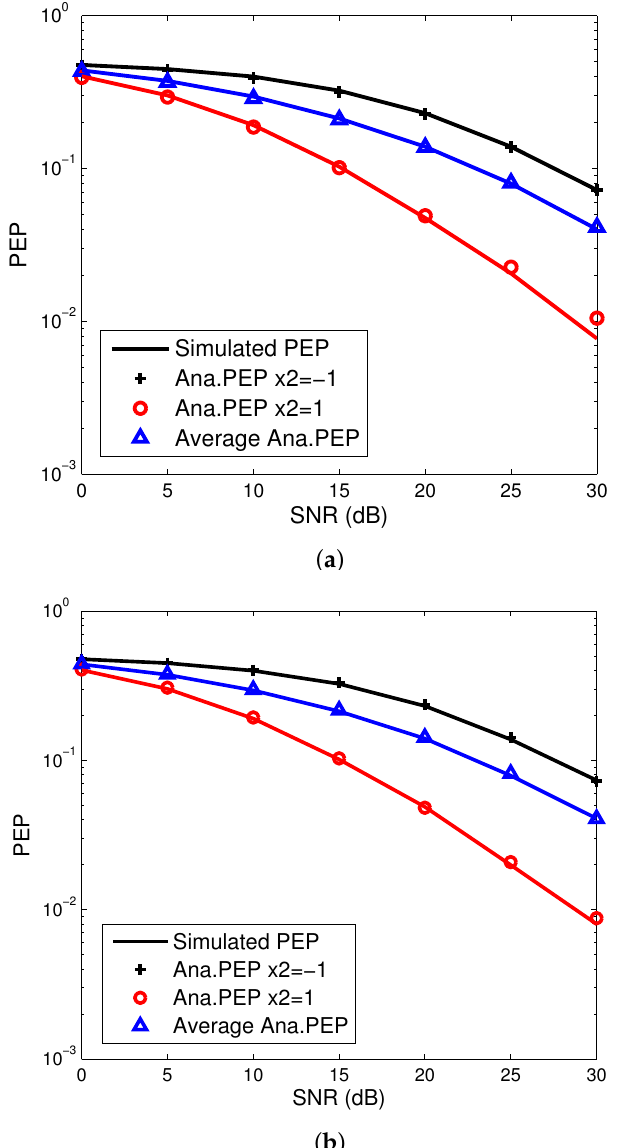
Figure 2. Simulated and Analytical pairwise error probability (PEP) for the first user. ( a ) ( Q , Q (cid:48) ) = ( 4,4 ) ; ( b ) ( Q , Q (cid:48) ) = ( 2,8 )